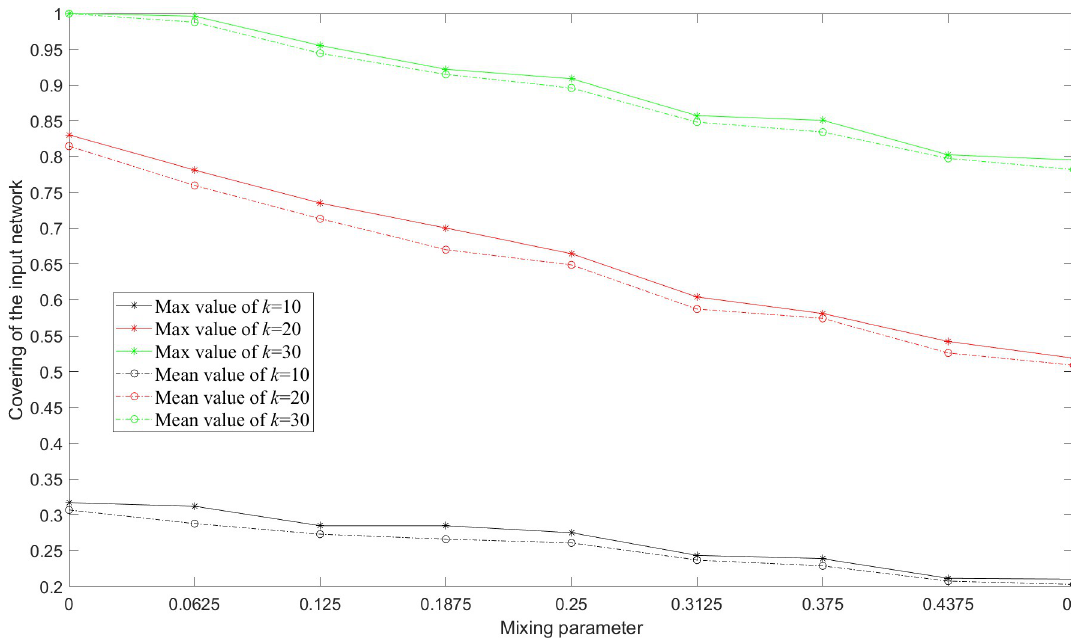
Fig 16. Covering of the benchmark networks for different mixing parameters given the number of subgraphs m = 10 and the subgraph size k = 10, 20 and 30 acquired by MA-M m C k SP.